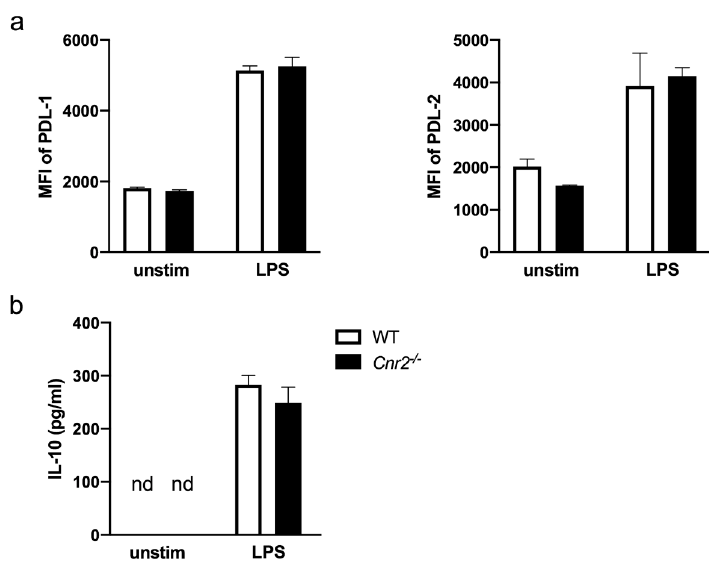
Figure 5. Equivalent surface expression of programmed death-ligand 1 (PD-L1), PD-L2 and IL-10 production by Cnr2 − / − and WT BM-DCs after TLR4 stimulation. ( a ) Surface expression of PD-L1 and PD-L2 by WT (white bars) or Cnr2 − / − (black bars) BM-DCs cultured for 16 h in the absence (unstim) or presence of 100 ng / mL LPS. ( b ) Production of IL-10 by WT (white bars) or Cnr2 − / − (black bars) BM-DCs cultured for 16 h in the absence (unstim) or presence of 100 ng / mL LPS. Data show median fluorescence intensity (MFI) ± SEM ( n = 3-4 animals/group).